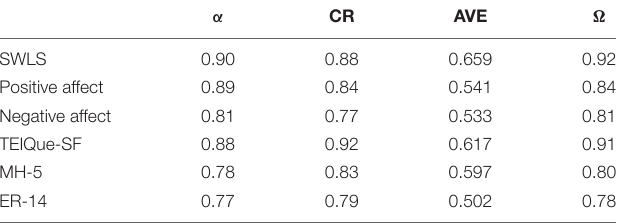
TABLE 1 | Reliability